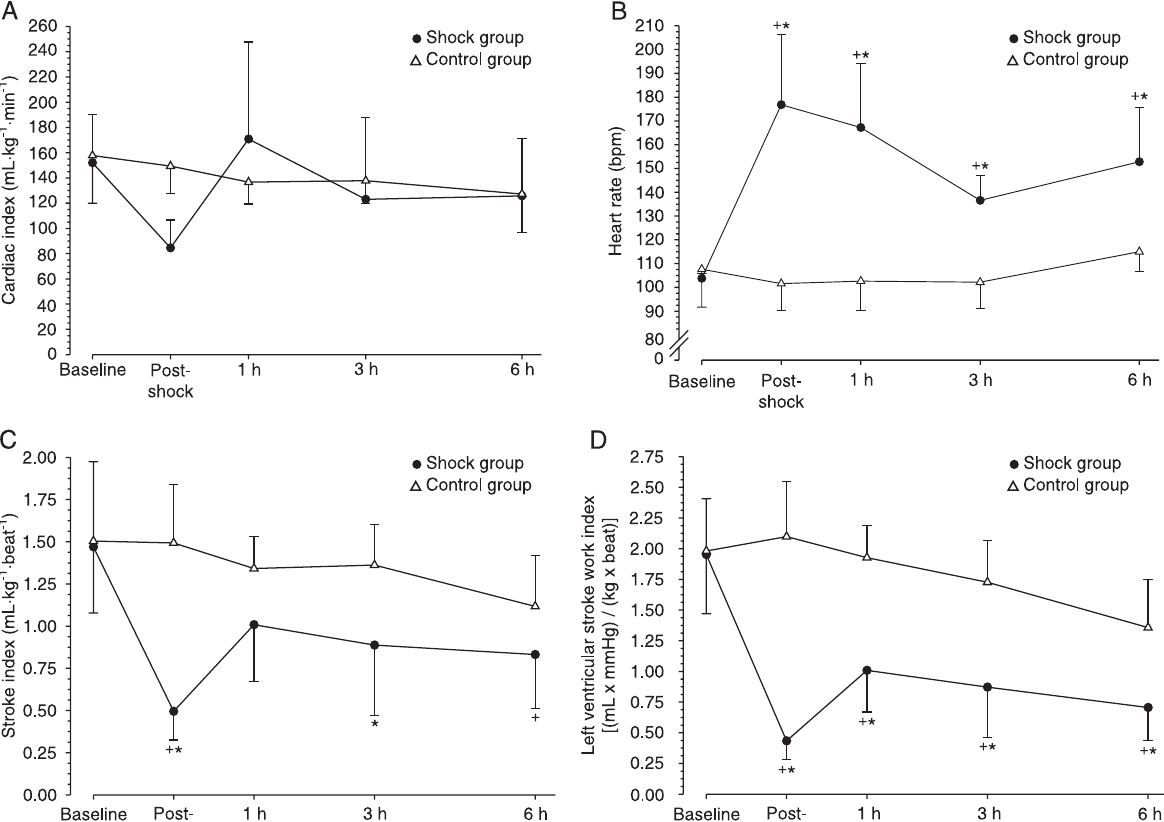
Figure 1. Evolution of hemodynamic parameters of pigs after cardiac tamponade shock. Filled circles = shock group; open triangles = control group. Panel A, cardiac index (two-way ANOVA: P = 0.378, between analysis; P = 0.186, within analysis and P = 0.148, factor x time interaction). Panel B, heart rate (two-way ANOVA: P < 0.001, between analysis; P < 0.001, within analysis and P < 0.001, factor x time interaction). Panel C, stroke index over time (two-way ANOVA: P < 0.001, between analysis x time interaction). Panel D, left ventricular stroke work index (two-way ANOVA: P < 0.001, between analysis; P < 0.001, within analysis and P < 0.001, factor x time interaction). Data are reported as means ± SD for 5 pigs in each group. *P < 0.05 vs control group (Tukey post hoc analysis). + P < 0.05 vs baseline (Tukey post hoc